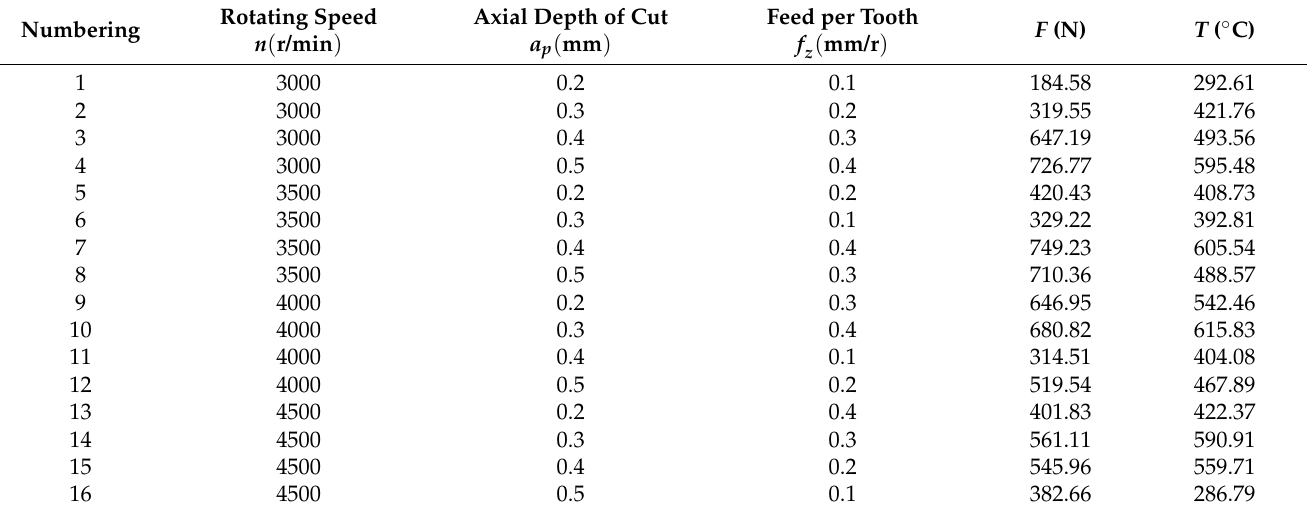
Table 2. Orthogonal simulation experiment